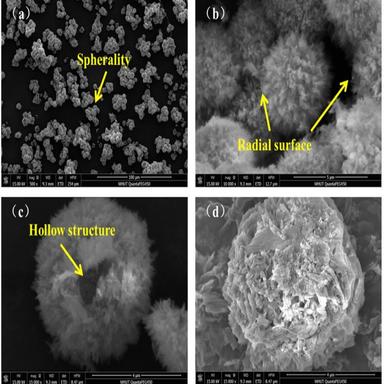
SEM micrographs of (a) and (b) synthesized HAP (c) porous HAP hollow microsphere (d) CA/hydroxyaptite CPCM.